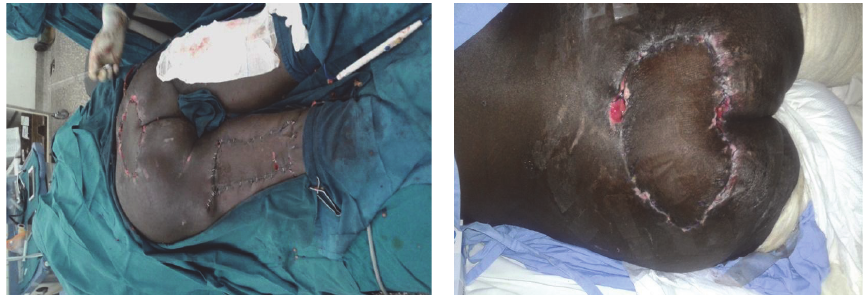
Figure 5: Skin graft of the donor site with the flap fully taken with no recurrence at one month after